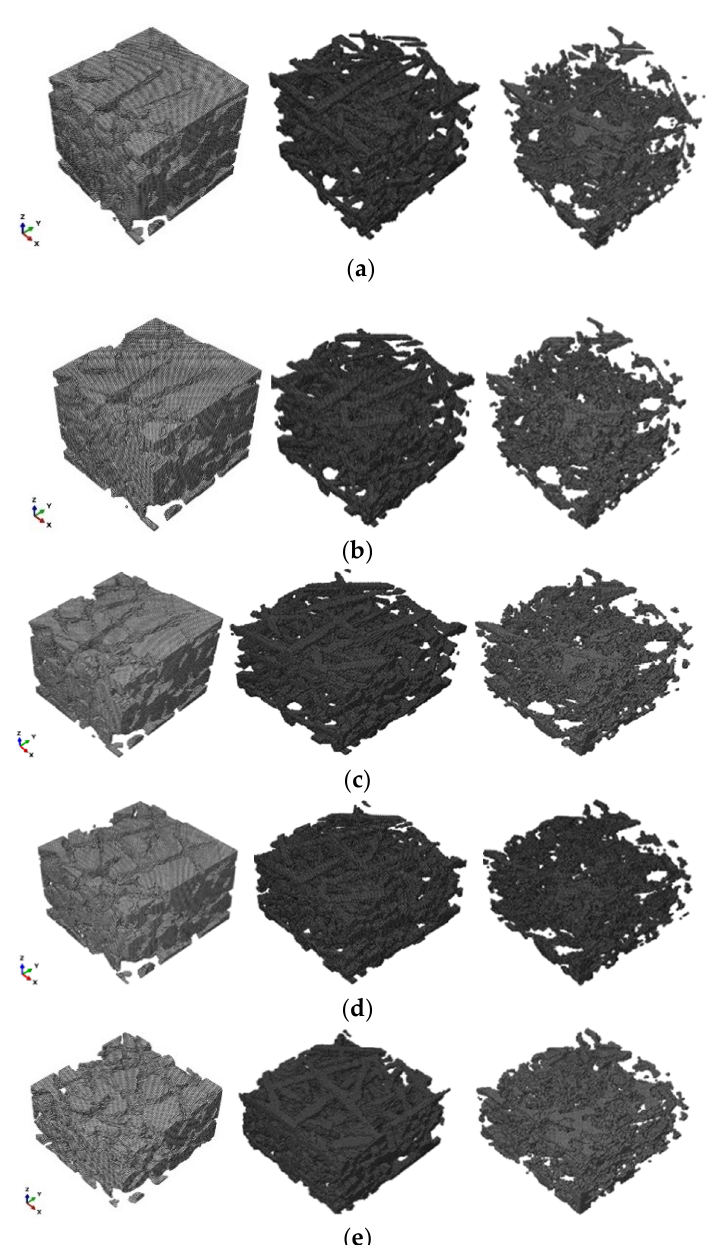
Figure 3. Generated fiber network of unit-cell: ( a ) 10% compressed gas diffusion layer (GDL) model; ( b ) 20% compressed GDL model; ( c ) 30% compressed GDL model; ( d ) 40% compressed GDL model; ( e ) 50% compressed GDL model.